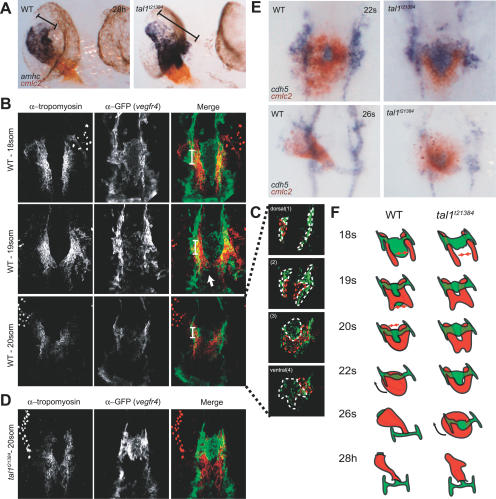
Defective Heart Tube Formation in tal1t21384 Mutant Embryos Despite Normal Fusion of Bilateral Myocardial Precursor Populations(A) Chamber differentiation in wt and tal1t21384 mutant embryos revealed by two-color in situ hybridization showing amhc (atrium) and cmlc2 (atrium and ventricle) at 28 hpf. Chamber differentiation proceeds normal in mutant embryos, but the primary heart tube is malformed with an enlarged atrial inflow region (brackets).(B–D). Two-color immunohistochemistry using anti-tropomyosin (red, myocardium) and anti-gfp (green, vegfr4, endocardium) antibodies. Images were generated as maximum projections of confocal z-stacks (ventral views, anterior to the top). Some yolk platelets show intense autofluorescence at the wavelength used for anti-tropomyosin detection (647 nm). (B) Heart morphogenesis during heart field fusion in wt embryos. The bilateral heart fields fuse dorsal to the endocardium between the 18- and 20-somite stage. Fusion is initiated in the posterior region of the heart. At the 18-somite stage, tropomyosin-positive cells are located ventral to the first aortic arches. (C) Endocardial precursors are ventral to the myocardium in the lateral and posterior regions of the heart. Endocardial and myocardial sheets are closely associated, as relative positions were only revealed after deconvolution of confocal stacks. Four deconvolved images of the confocal image stack in (B) are shown in (C). (D) In tal1t21384 mutant embryos, initial fusion of the myocardial precursor populations occurs normally, although endocardial precursors are absent in the posterior region of the heart field.(E) Primary heart tube formation from myocardial and endocardial precursors in wt and tal1t21384 mutant embryos revealed by two-color in situ hybridization showing cdh5 (endocardium, blue) and cmlc2 (myocardium, red) expression. Dorsal views, anterior is to the top. At the 22-somite stage, wt embryos have formed a cardiac disc, with endocardial cells underlying the circular myocardial primordium. The medial endocardium within the ring of myocardium forms the connection between the endocardium and the aortic arches. In tal1t21384 mutant embryos, anterior closure of the myocardial primordium is defective due to aggregation of endocardial precursors. At the 26-somite stage, wt embryos have formed the primary heart tube and rhythmical contractions begin. In tal1t21384 mutant embryos, heart tube formation is delayed. By this stage, myocardial cells have completed fusion formation at the anterior side of the cardiac disc.(F) Schematic overview of fusion of myocardial precursor regions and heart tube formation in wt and tal1t21384 mutant embryos. Endocardium and aortic arches are in green, myocardium in red.